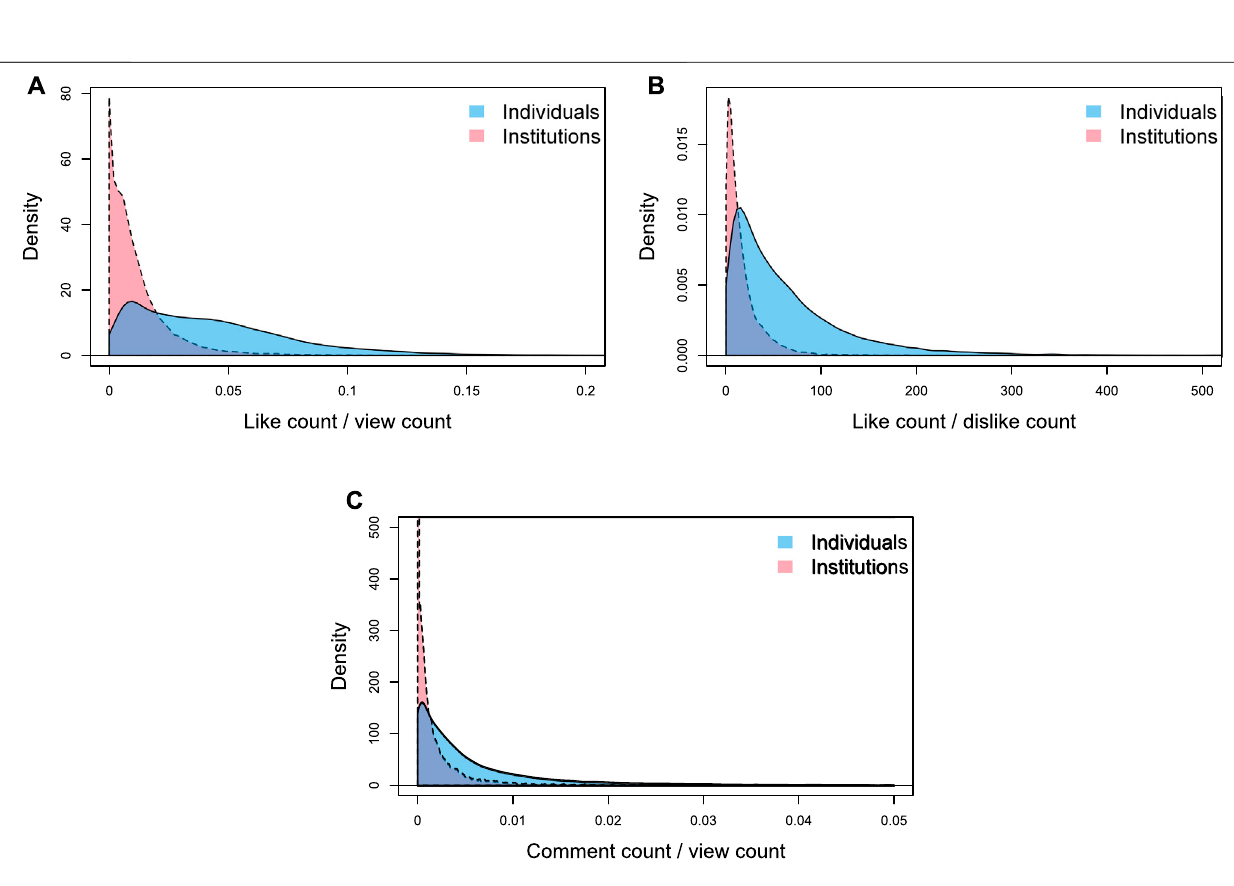
Frontiers in Communication |